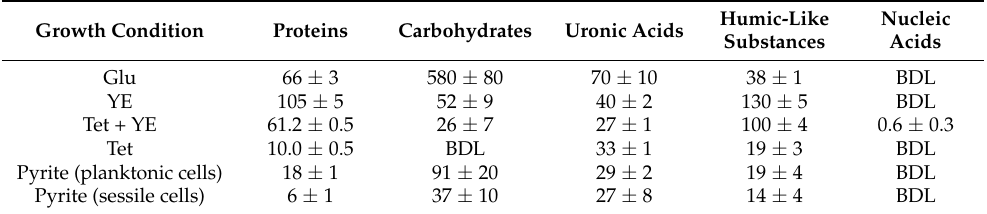
Table 2. Composition of EPS (mg/g-DW of EPS) produced by A. copahuensis grown under different conditions. Growth Condition Proteins Carbohydrates Uronic Acids